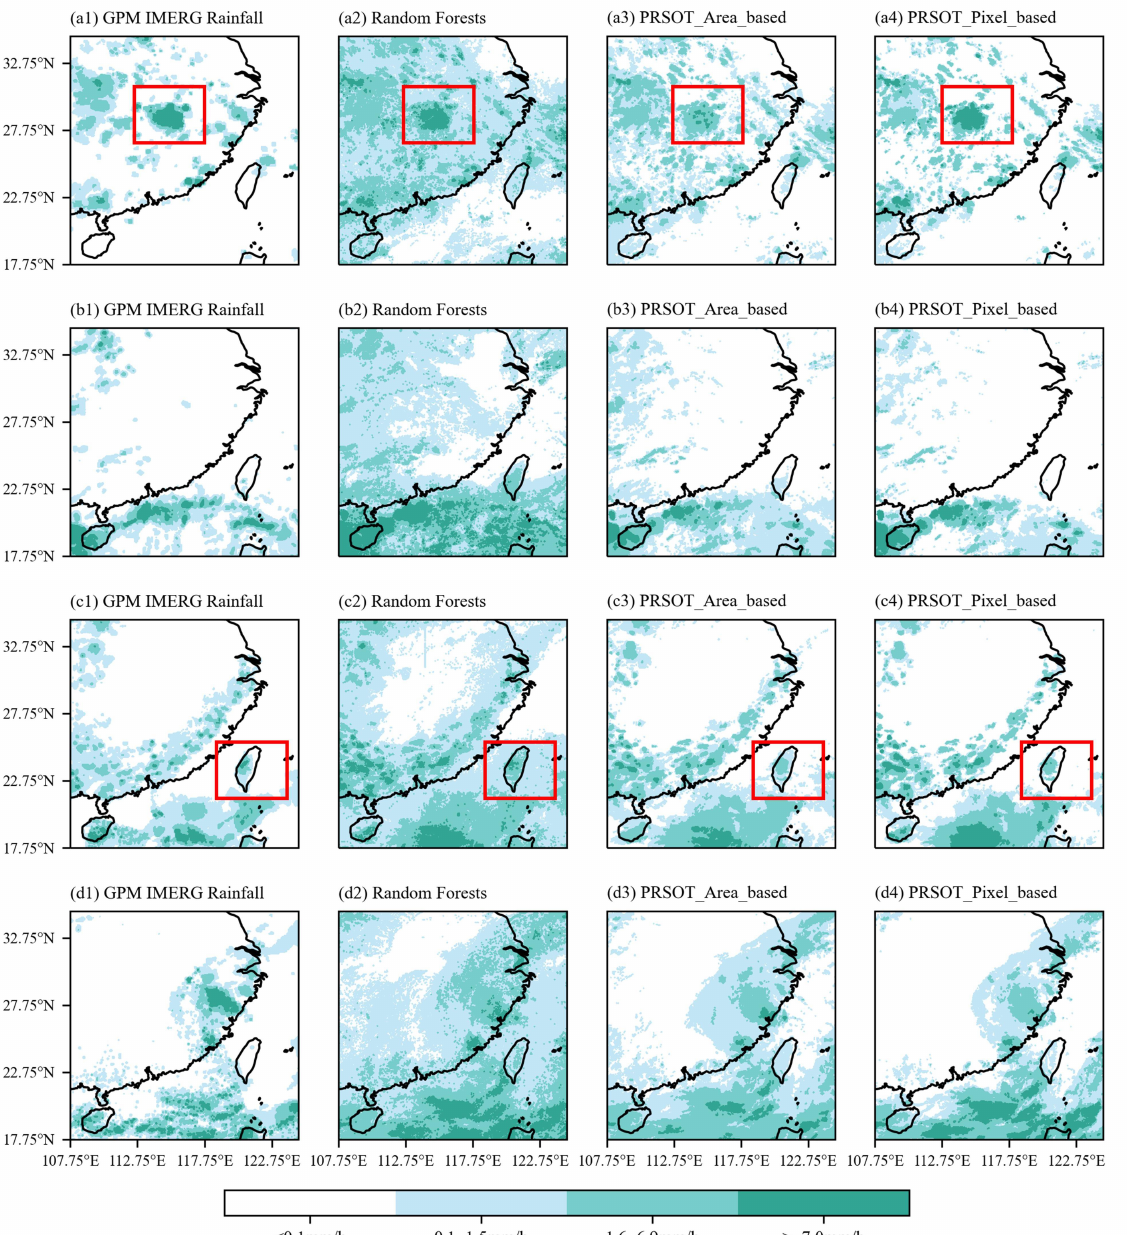
Figure 7c1–c4. At the same time, the prediction ability of heavy rain has been improved, as shown in the red box in the Figure 7a1–a4. However, PRSOT_Pixel_based model still has the defects of subtle differences in precipitation regions and inaccurate estimation grades. PRSOT_Pixel_based model tends to overestimate some Moderate Rain samples as Heavy Rain, consistent with Confusion Matrix results. This feature is more pronounced in the sea area. The distribution trends of Model Estimates and GPM precipitation are consistent, but the estimated grades are different in some regions. The PRSOT_Pixel_based model has the ability to invert precipitation on sea area, which can further supplement ground observations.